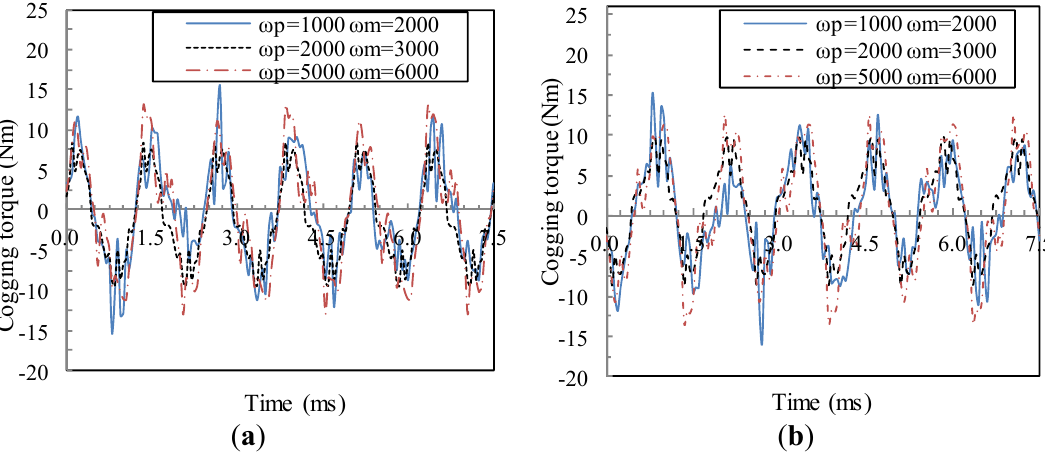
Figure 12. Cogging torque waveforms: ( a ) cogging toque waveform of the permanent magnet rotor; and ( b ) cogging torque waveform of the modulating ring